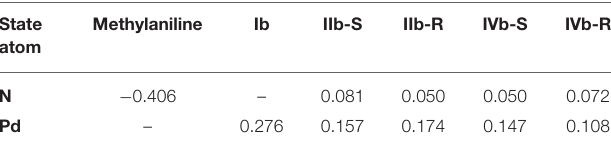
TABLE 1 | The ADCH charge of the N and the Pd in different states for Pd-L catalytic